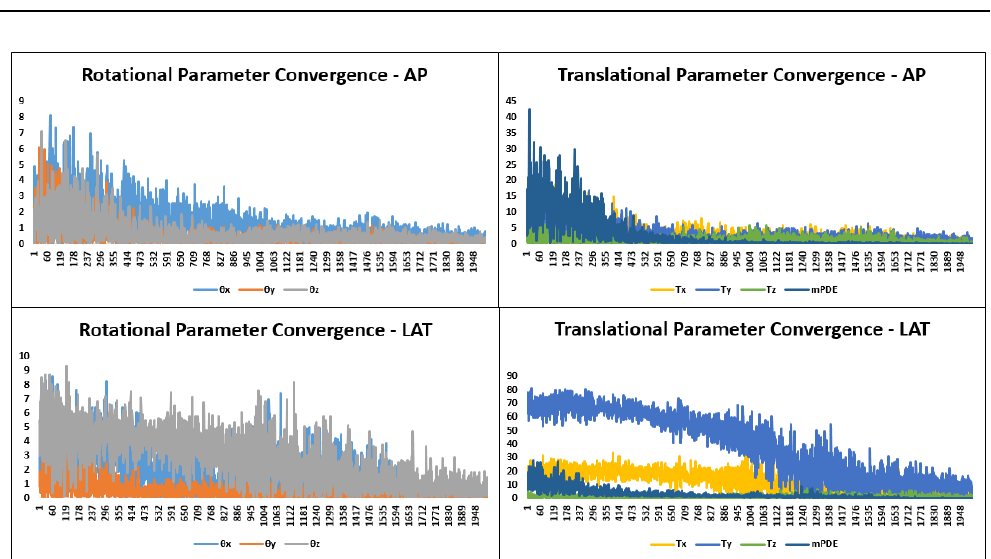
Figure 5. Transformation parameter and mPDE convergence during the optimization in AP and lateral planes are displayed about the final estimation over successive number of